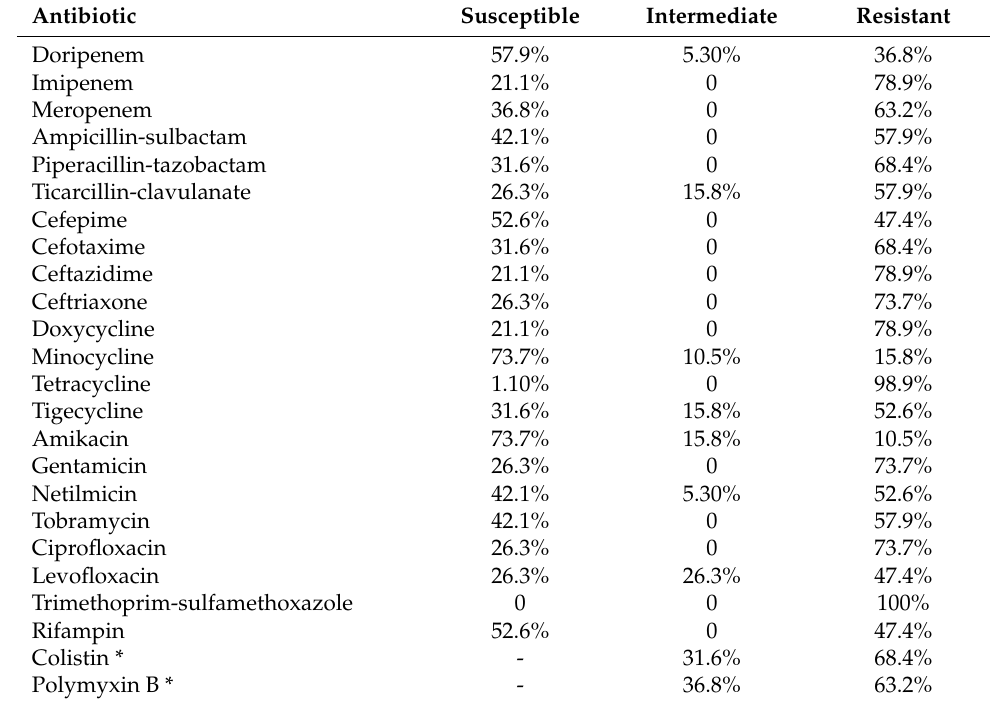
Table 1. Summary of A. baumannii susceptibility to standard-of-care antibiotics.